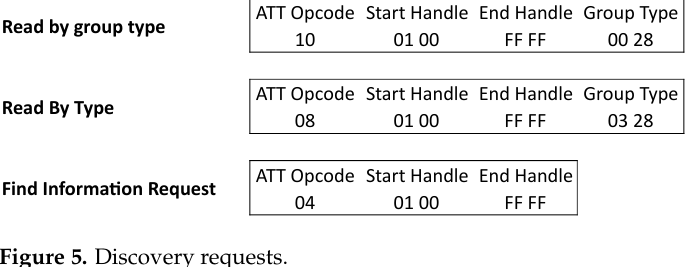
Figure 5. Discovery requests.